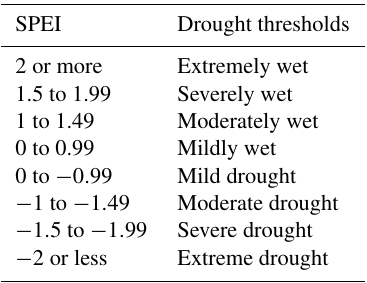
Table 1. Definition of drought thresholds based on the SPEI